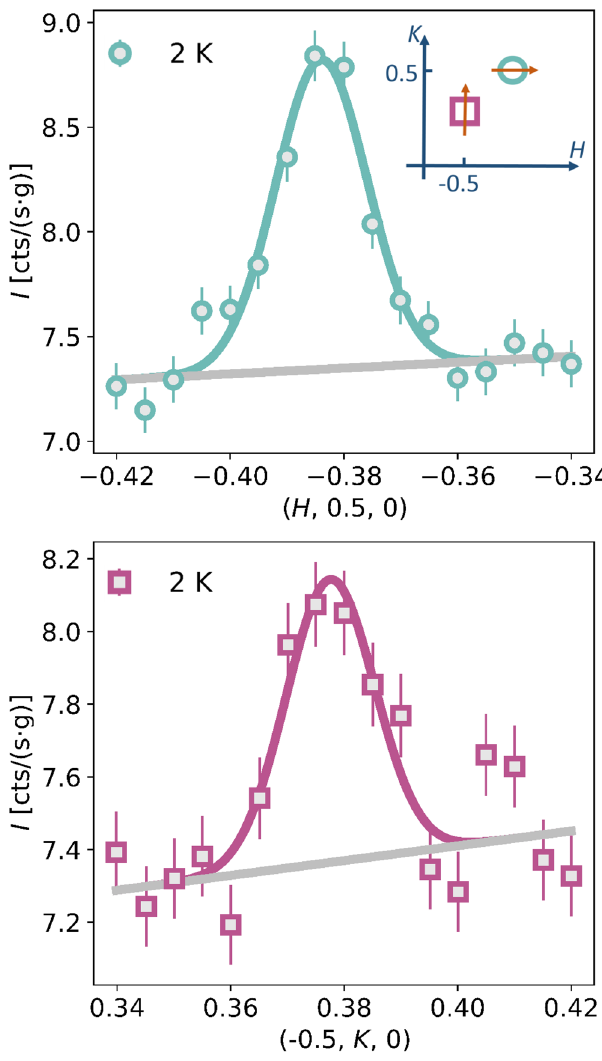
elastic magnetic neutron scattering intensity along the two reciprocal space directions indicated in the inset. The La measured at ambient pressure and T = 2 K. Intensities ( I ) are given in counts (cts) per seconds (s) and mass (g) of the sample. Error bars are dictated by Poisson statistics. Scans through Q a (squares) reveal magnetic intensity at both wavevectors. The data were fi tted with a Gaussian line shape on a sloping